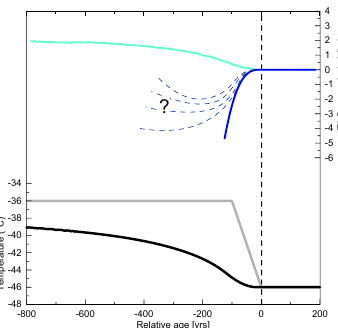
Figure 11. Modeled behavior of TAC for an idealized DO event with a 10 ◦ C linear surface warming during 100 years after the on- set of the event. At the bottom, in grey, the assumed surface tem- perature and in black the temperature at bubble close-off depth. At the top, in turquoise, the TAC model output for steady-state firni- fication conditions (Eq. 11). Blue: the transient firnification model (Schwander et al., 1997) TAC output for a constant bubble close-off time. Dashed lines indicate the range of measured TAC